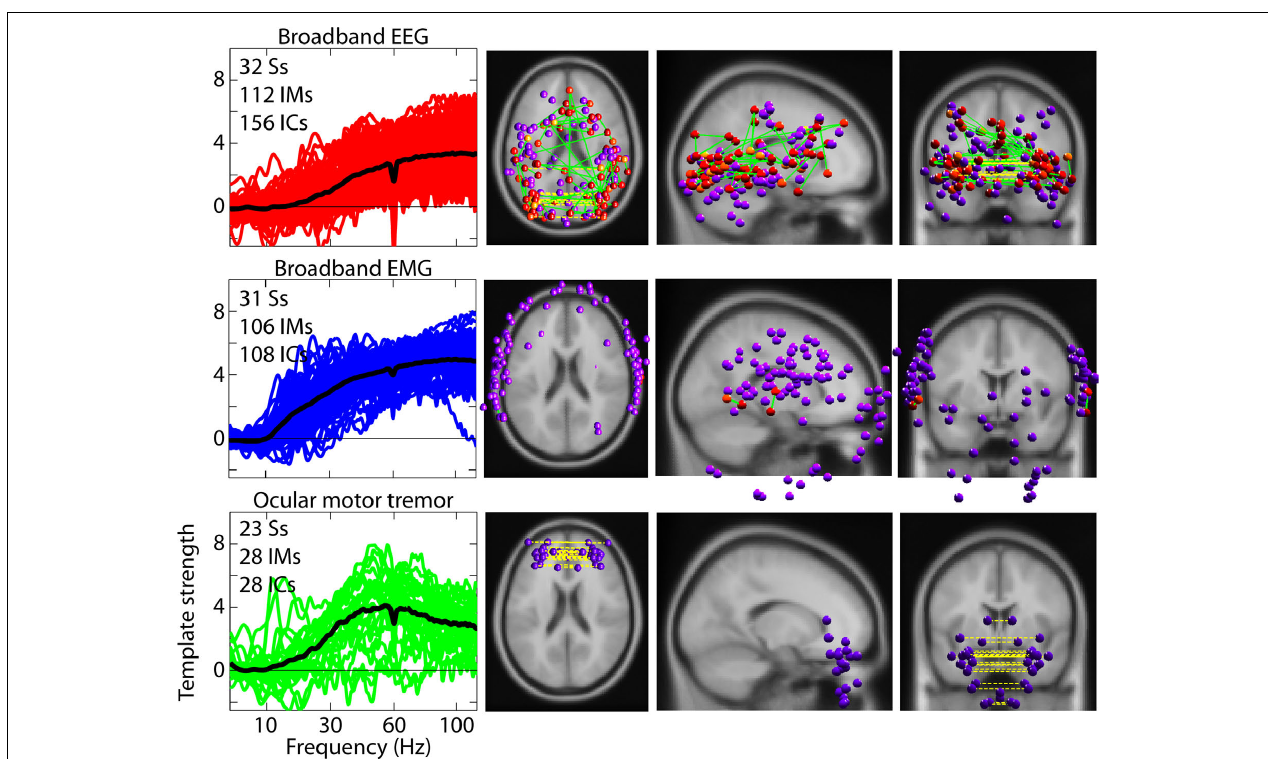
FIGURE 4 | Broadband independent modulators of brain and scalp muscle components. Brain and scalp muscle ICs are separately modulated by IMs with similar broadband high-frequency templates (upper rows). The left column shows broadband templates for each IC category (black trace is the mean). The right three columns show equivalent-dipole locations of the affected ICs. A distinct cluster of putative ocular motor IMs, shown in the bottom row, have a peak effect near 50 Hz on ICs many of whose bilaterally symmetric equivalent-dipole models